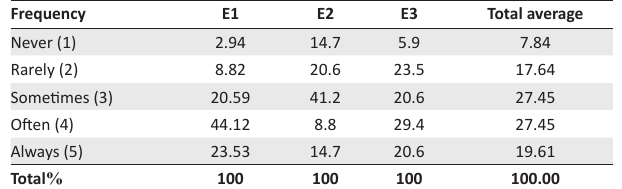
TABLE 5 : Participation in the MuniMEC inter-government relations